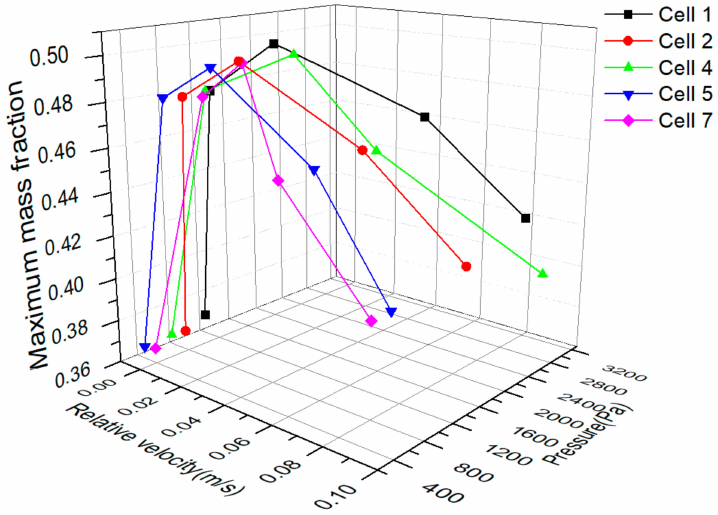
Figure 11. Simulation results of cell surfaces maximum rhodamine mass fraction influenced by the relative velocity of microdroplet and cell surfaces